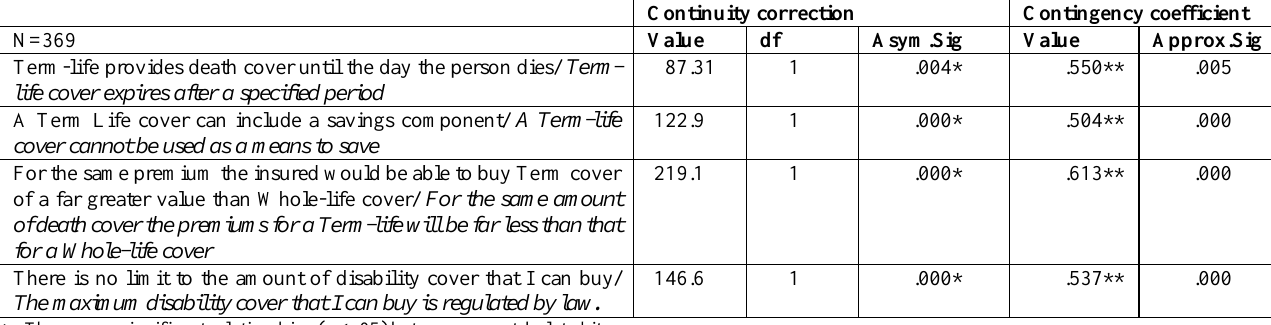
Table 3: Cross-tabulation matrix for responses to knowledge questions